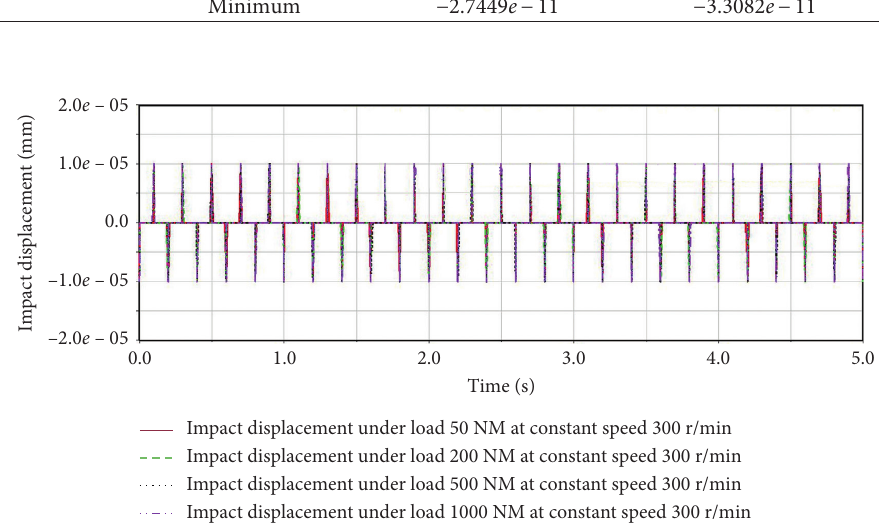
Figure 12: Impact elastic displacement of second-stage face gear pair under variable